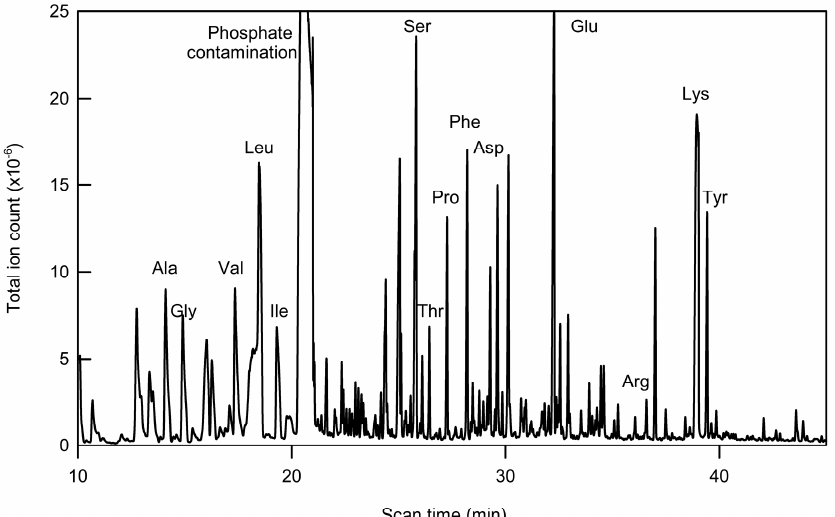
Figure 3. Chromatographic (GC/MS) analysis of amino acids after hydrolysis of GFP isolated from roots of liquid cultured A. thaliana seedlings. Immunopurified GFP from three cultures of 30–50 seedlings constitutively expressing the reporter protein was pooled, hydrolysed and derivatised with tBDMS in pyridine. The total ion chromatogram shows peaks from 14 amino acids, as well as many contaminating signals, including phosphate.